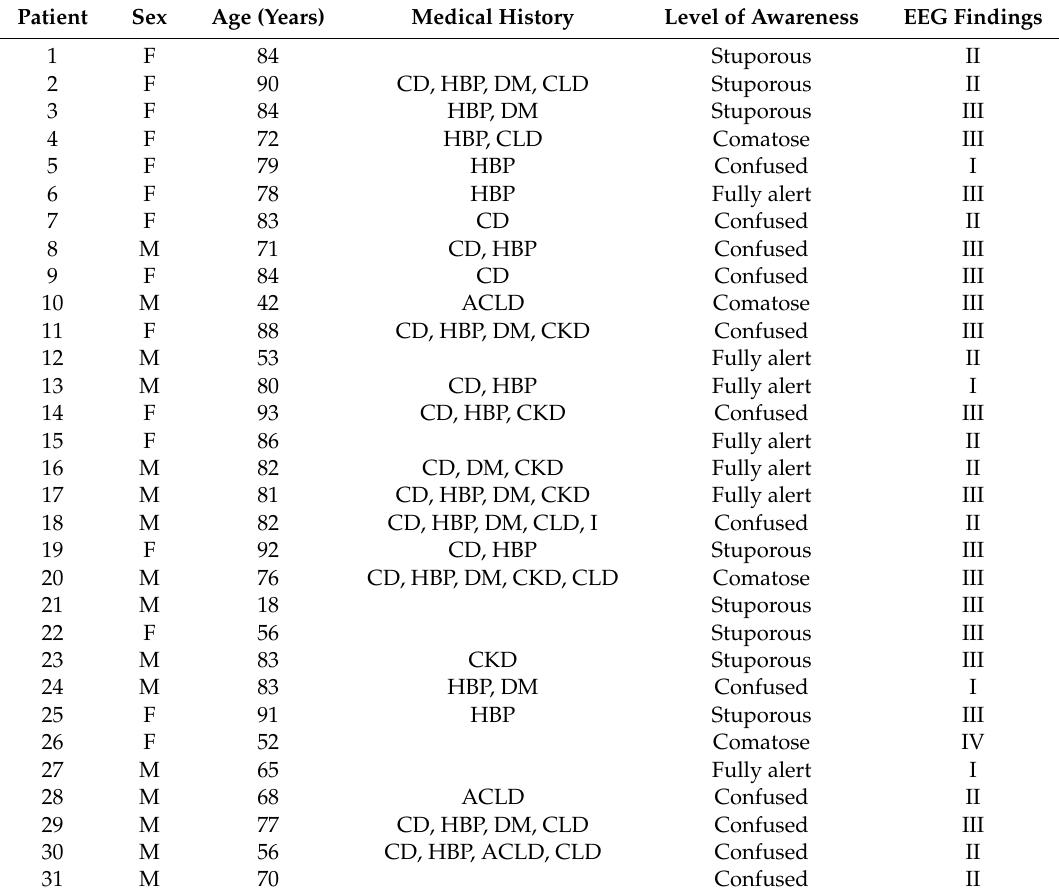
Table A1. Patients with infectious toxic encephalopathy